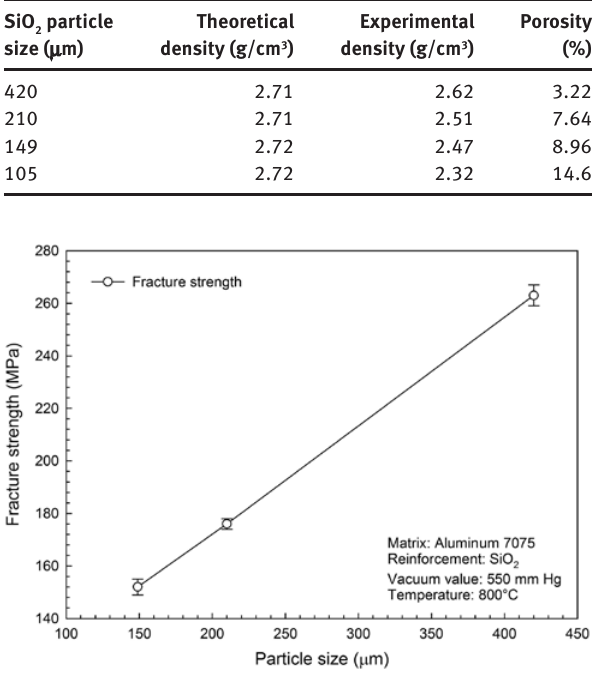
Figure 5: The relationship between reinforcement particle size and fracture strength.